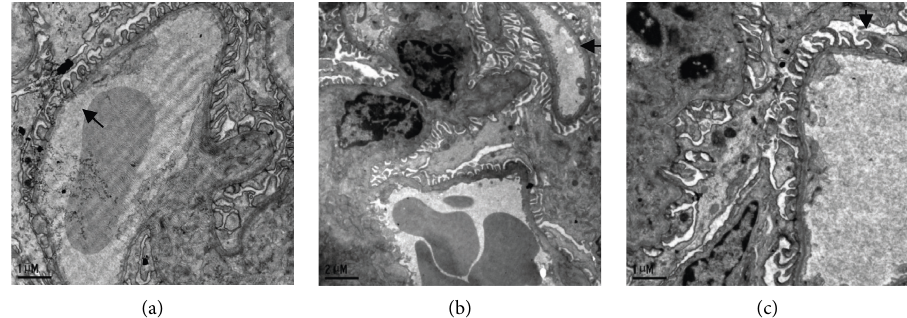
Figure 5: High-dose group. (a) No basement membrane thickening, uniform, no podocyte fused or decreased. (b) Basement membrane thickness was uniform and clear, podocyte in order, no fusion. (c) No podocyte flatting, decreasing, basement membrane was clearly